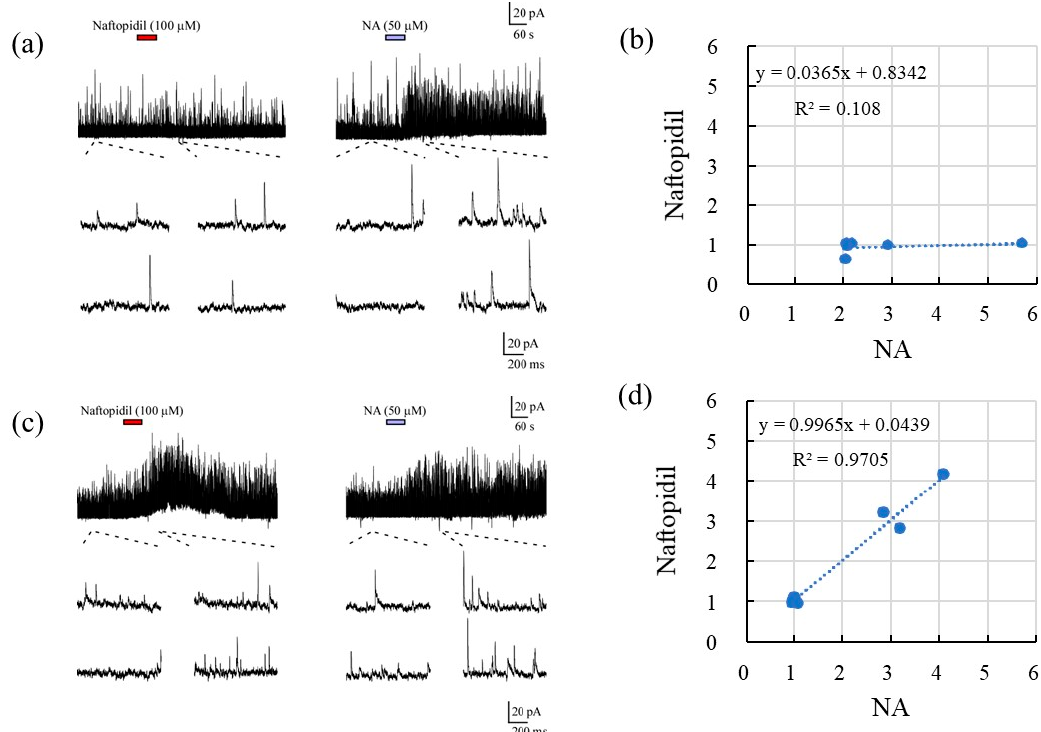
Figure 3. A stratified analysis of the sIPSCs for the frequency ratio response to NA (50 μ M) and naftopidil (100 μ M). The SG neurons exposed to naftopidil (100 μ M) showed either a poor response ( a , b ) or a good response ( c , d ). Typical traces of both types are shown for a single SG neuron in ( a , c ), respectively. The associations of the response ratios between NA and naftopidil are plotted for each SG neuron ( b , d ). The x and y axes reveal the ratio of frequency or amplitude of sIPSCs after adding the drugs (NA, 5-HT, prazosin, or naftopidil) to before the adding in the single SG neuron.